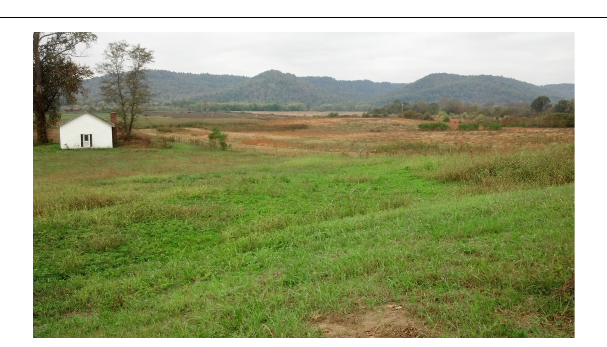
FIGURE 2 | General view of now vegetated hummocky landscape west of U.S. Route 52 including the area containing complex dunes and barchan-like